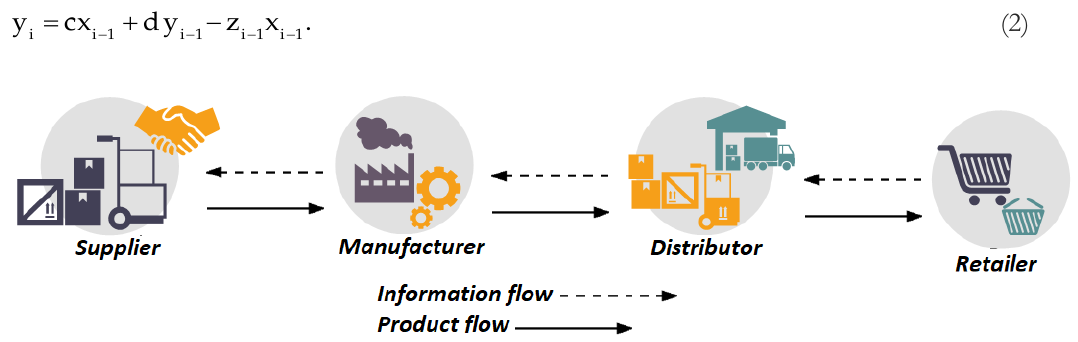
Fig. 1. Schematic representation of a four-level supply